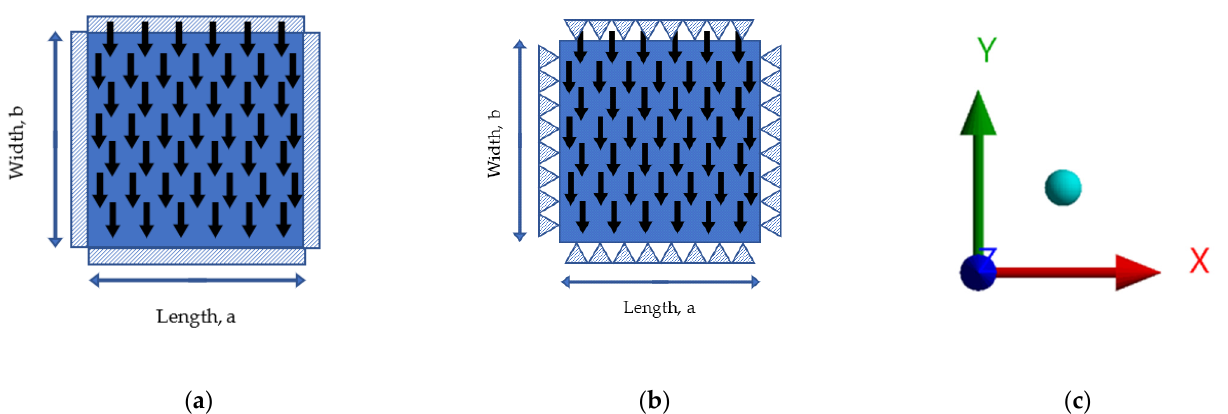
Figure 3. Boundary conditions of numerical models. ( a ) Plate with fixed boundary conditions; ( b ) plate with simply supported boundary conditions; ( c ) coordinate system of plates (x,y,z).